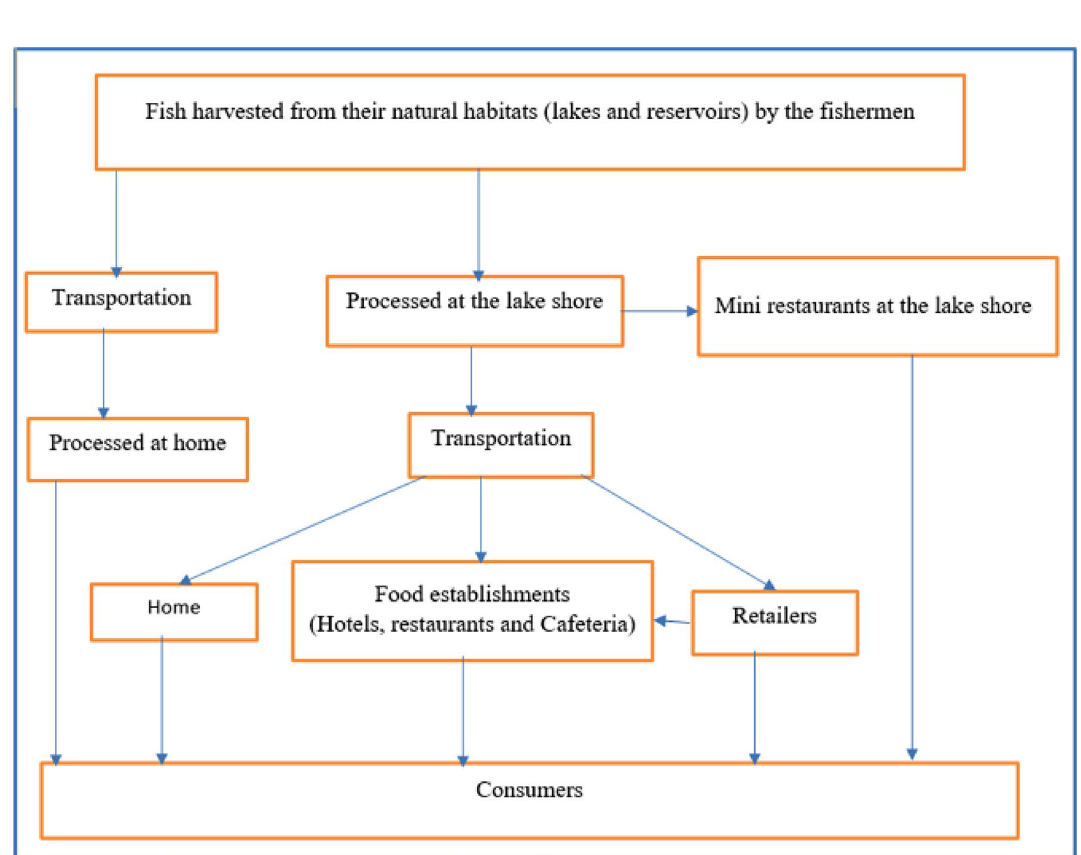
Figure 1. Conceptual flow diagram showing fish production and supply chain in east Shewa zone of Oromia,